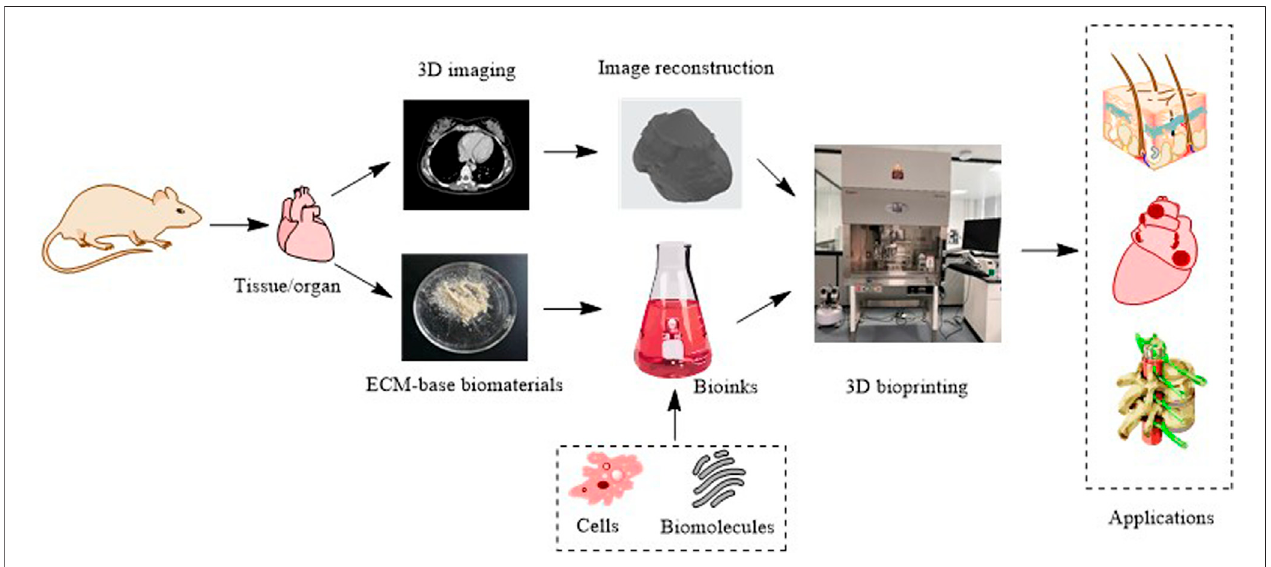
FIGURE 2 | The schematic of 3D bioprinting.